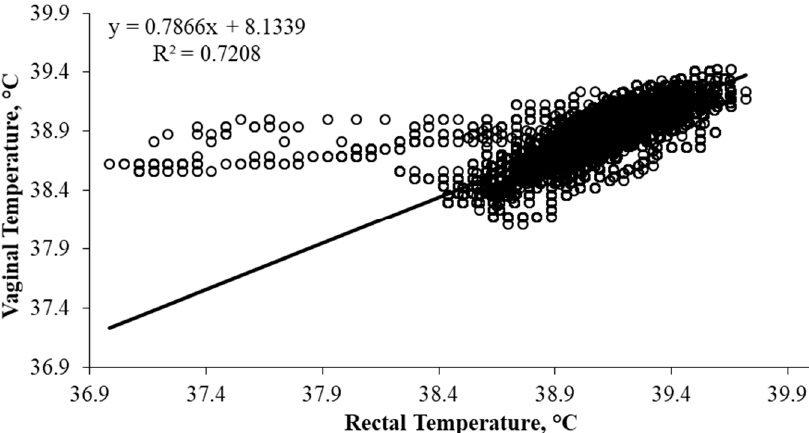
Figure 3. Linear relationship between rectal temperate (T REC , °C) and vaginal temperature (T VAG , °C) using data recorded at twenty second intervals.